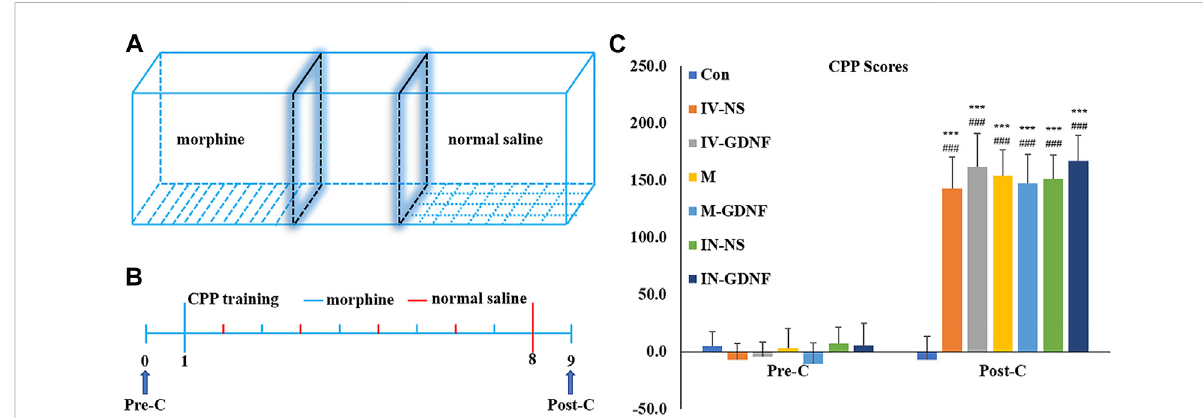
FIGURE 2 Morphine-induced CPP in rats. (A) CPP training diagram. (B) CPP training protocol. (C) CPP scores. Means ± SEM, n = 8, *** p < 0.001 vs . Pre-C; ### p < 0.001 vs . control group. CPP, conditioned place preference.